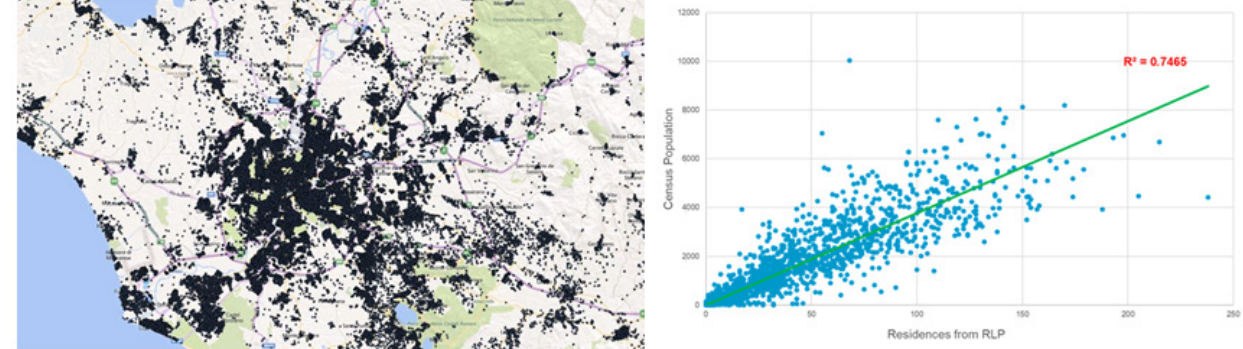
Figure 1. Map of the residences after the application of the residence location procedure and comparison with census data.